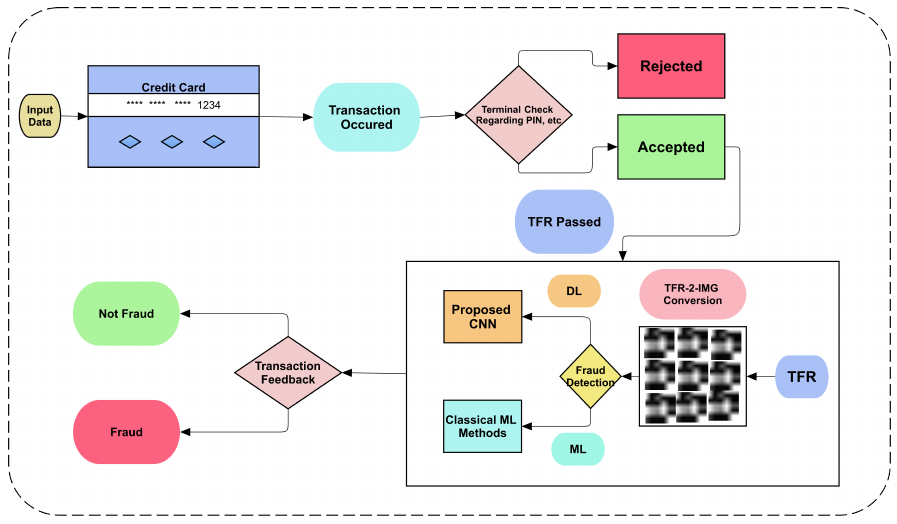
Figure 1. Flowchart of proposed